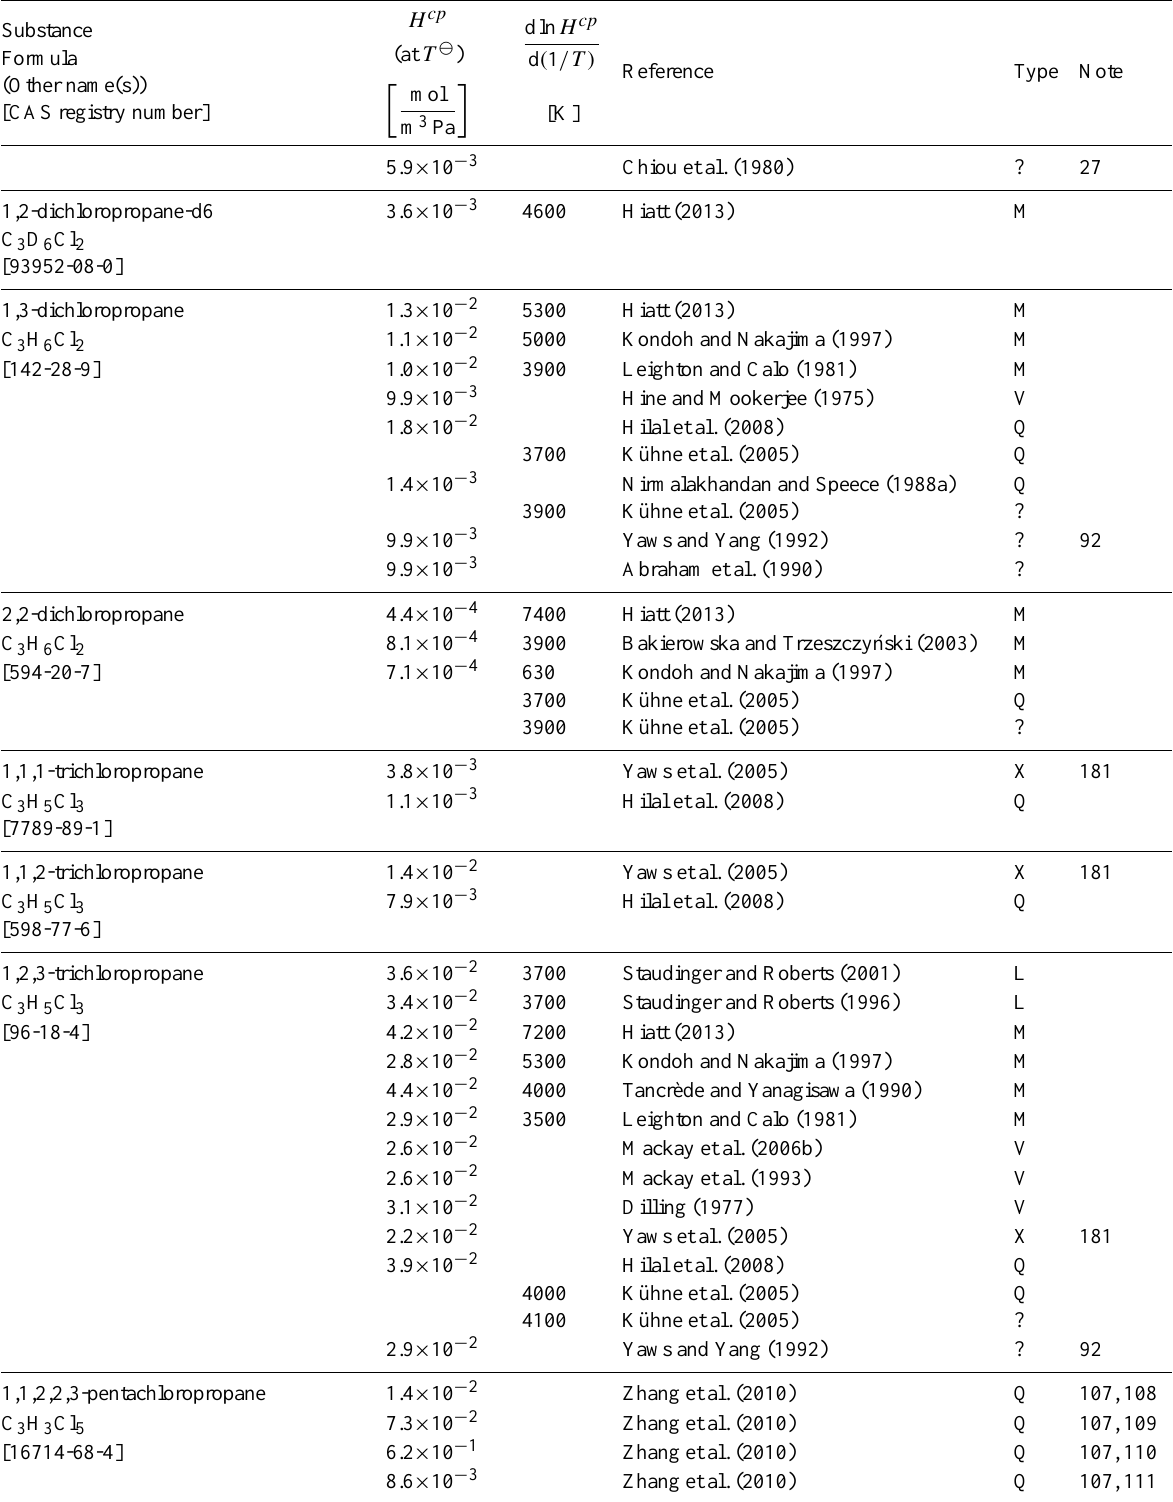
Table 6: Henry’s law constants for water as solvent